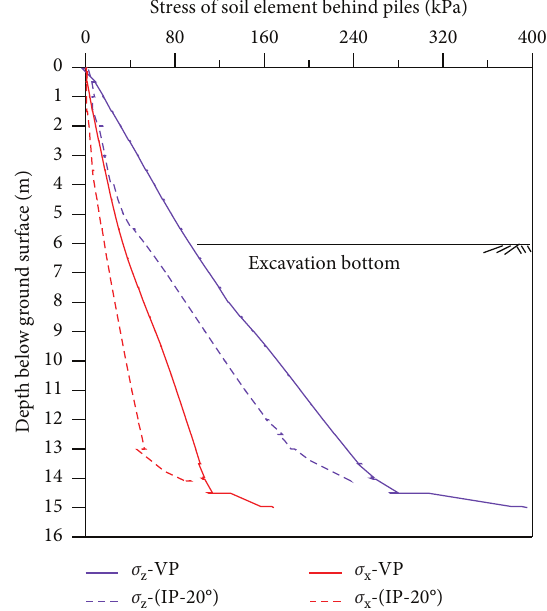
Figure 12: Soil element stresses behind VP and IP with an angle of 20 °